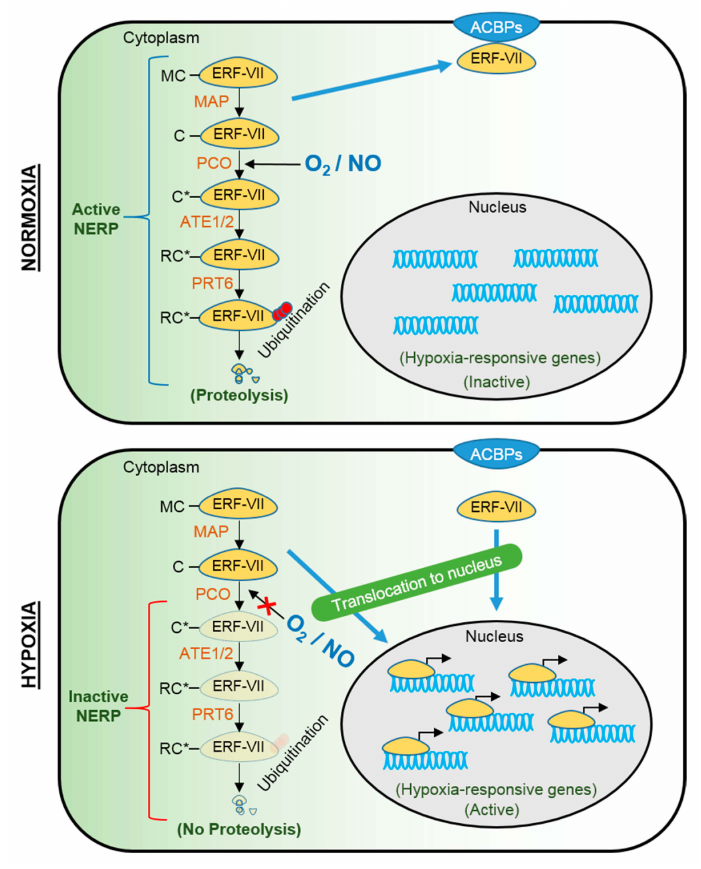
Figure 3. Oxygen-dependent stabilization and localization of ERF-VII proteins. Under oxygen-replete conditions (normoxia), ERF-VII proteins are degraded via the N-end rule pathway of proteolysis (NERP). All ERF-VII proteins contain methionine and cysteine (MC) at the N-terminal [25] and the first methionine (M) is constitutively cleaved by methionine aminopeptidase (MAP) [36]. The exposed cysteine (C) is converted to Cys-sulfinic or Cys-sulfonic acid (C*) by plant cysteine oxidase (PCO) [37,38]. An arginine residue (R) is added to the oxidized cysteine (C*) by arginyl t-RNA transferases (ATE1/2), which is recognized and ubiquitinated by an E3 ubiquitin ligase, PROTEOLYSIS6 (PRT6) [1,36]. The ubiquitinated ERF-VII proteins are targeted for proteasomal degradation. Under oxygen deprivation (hypoxia), oxidation of cysteine by PCO is inhibited, resulting in the escape of ERF-VII proteins from targeted proteolysis and activation of hypoxia-responsive genes. Alternatively, at least one ERF-VII protein, RAP2.12, physically interacts with